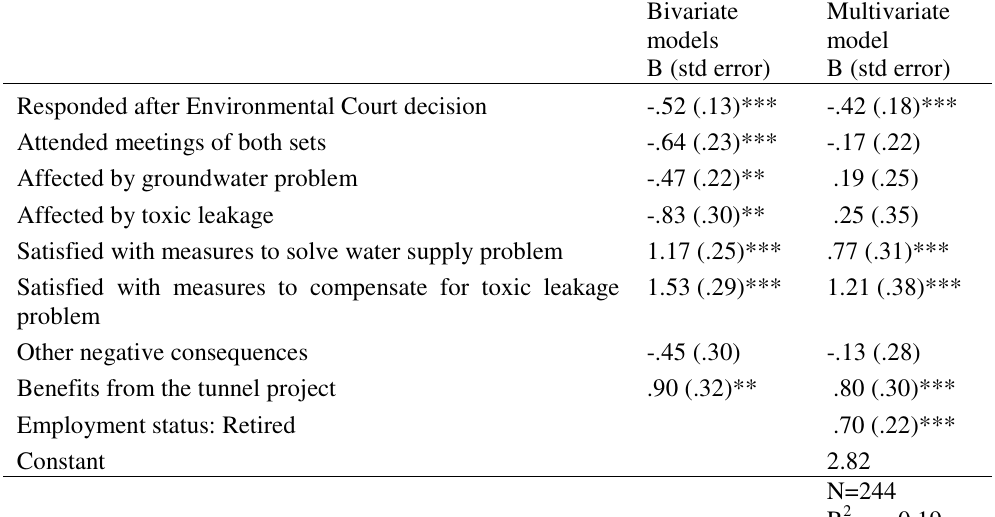
Table 5. Factors potentially affecting the perceived fairness of the deliberative participation (OLS unstandardized